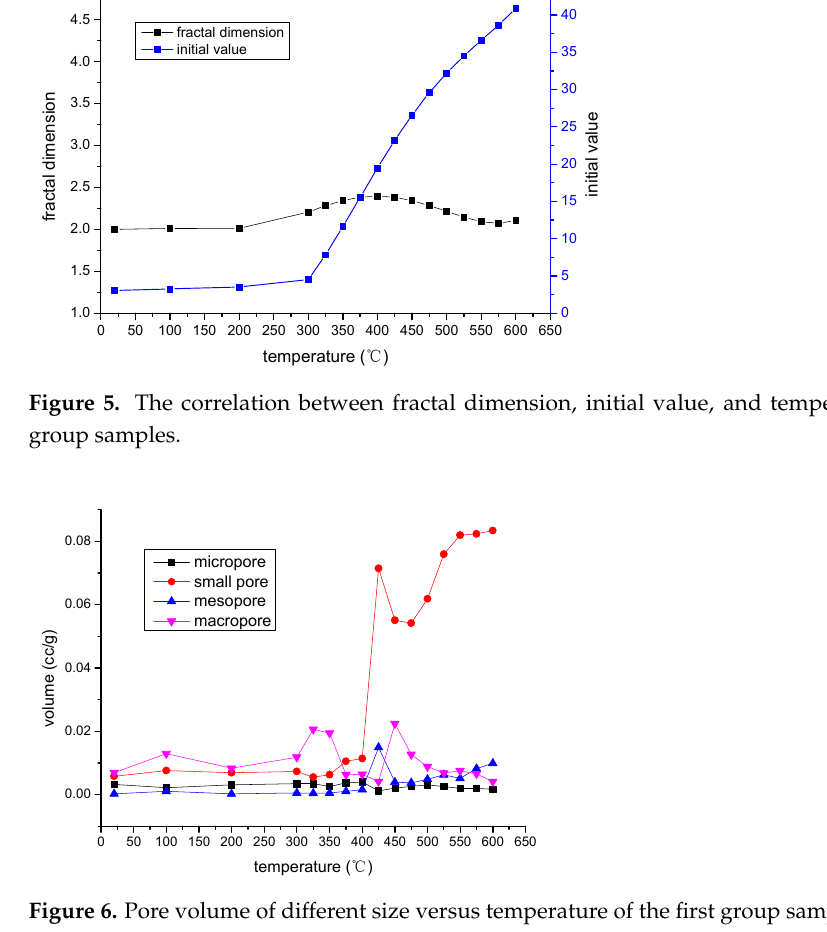
Figure 7. The percentage of different groups versus temperature of the first group samples.